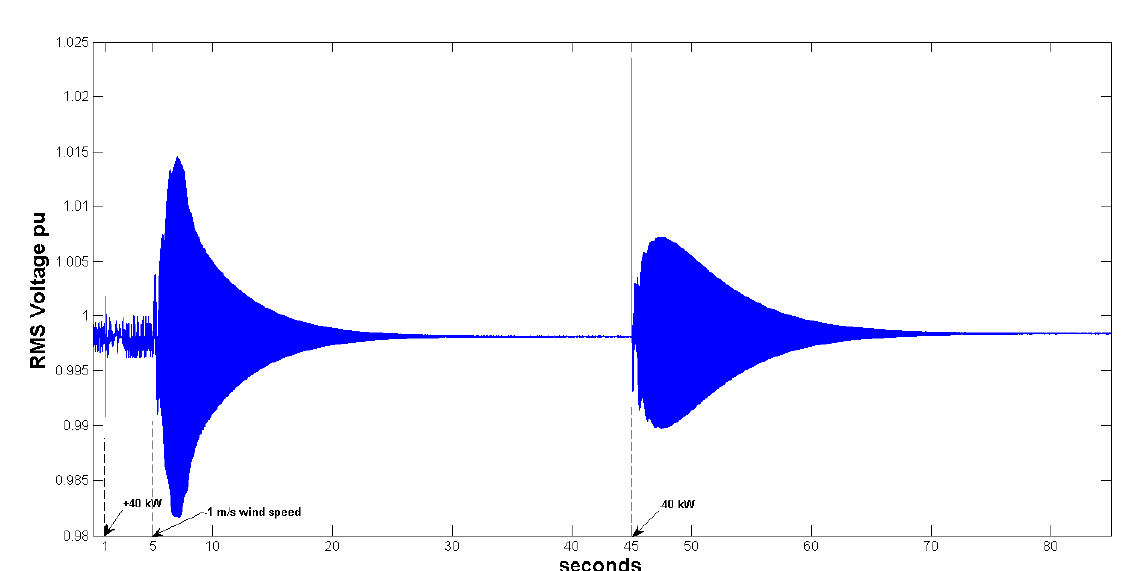
Figure 8. Microgrid frequency in p.u.